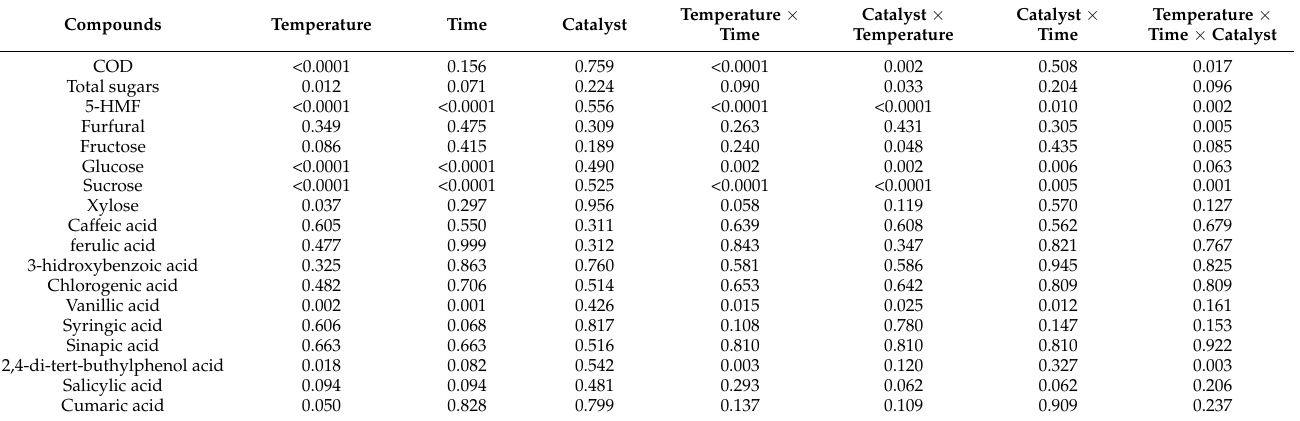
Table 2. The effect of temperature, time, and catalysts on the different